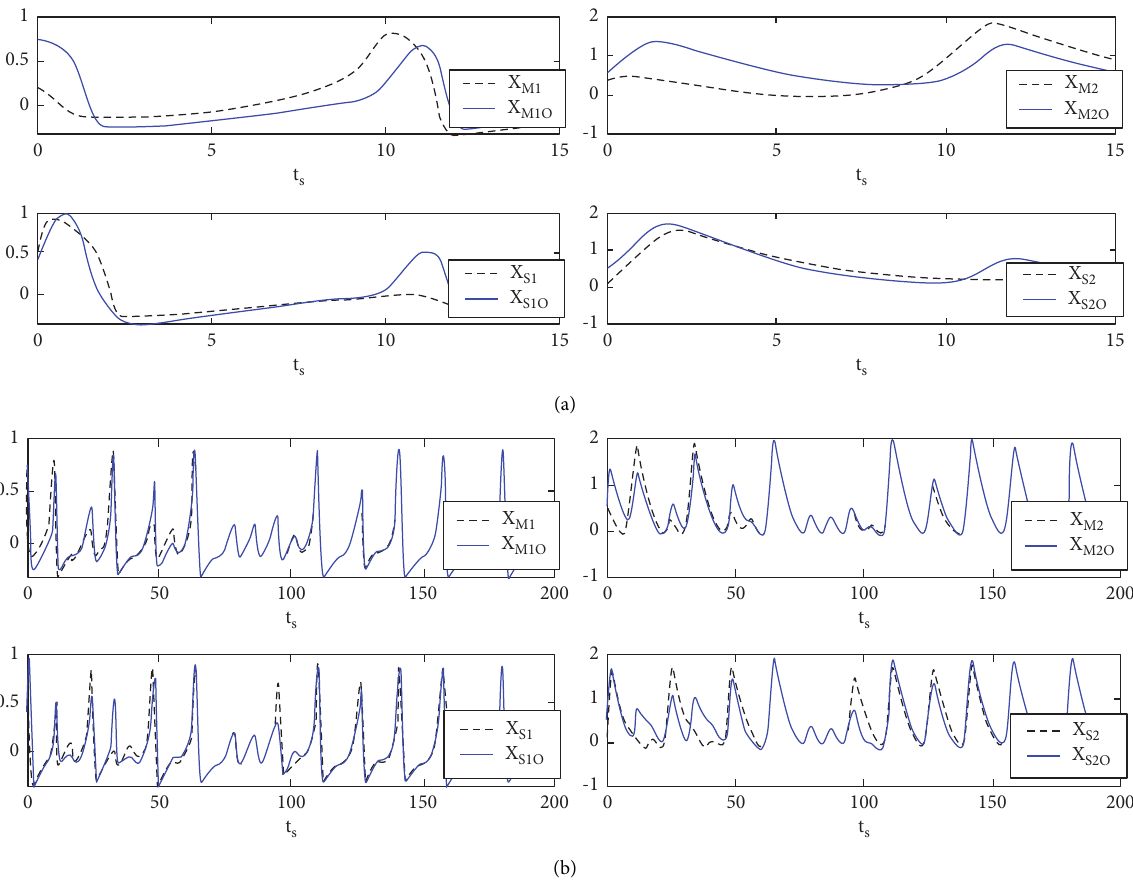
Figure 1: (a) Standardized potential of the master and (b) four slave systems and their respective observers of Theorem